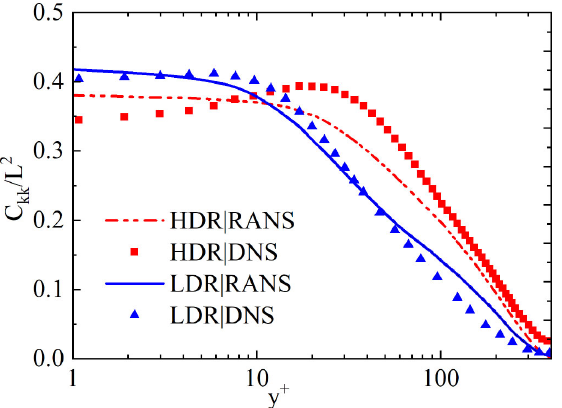
C is the compo ‐ kk